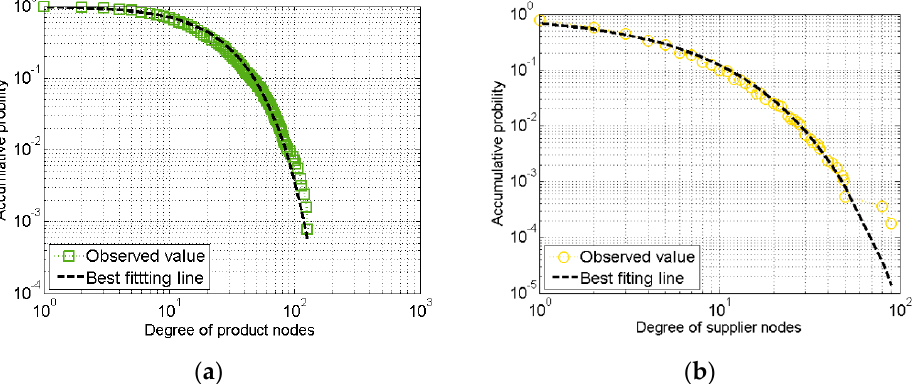
Figure 8. Degree distributions: ( a ) Product node degree distribution; ( b ) Supplier nodes degree distribution.